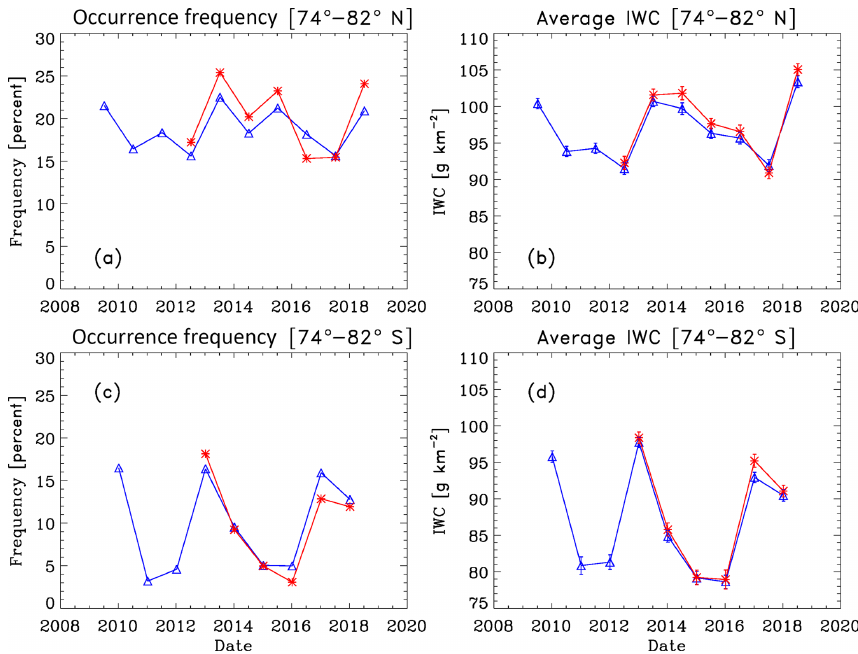
Figure 6. Season average occurrence frequency and IWC data at 74–82 ◦ latitude. Identifications are as in Fig. 4.